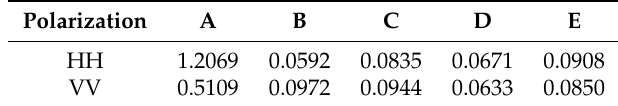
Table 5. The empirical coefficients of the parameterized combined scattering model at different